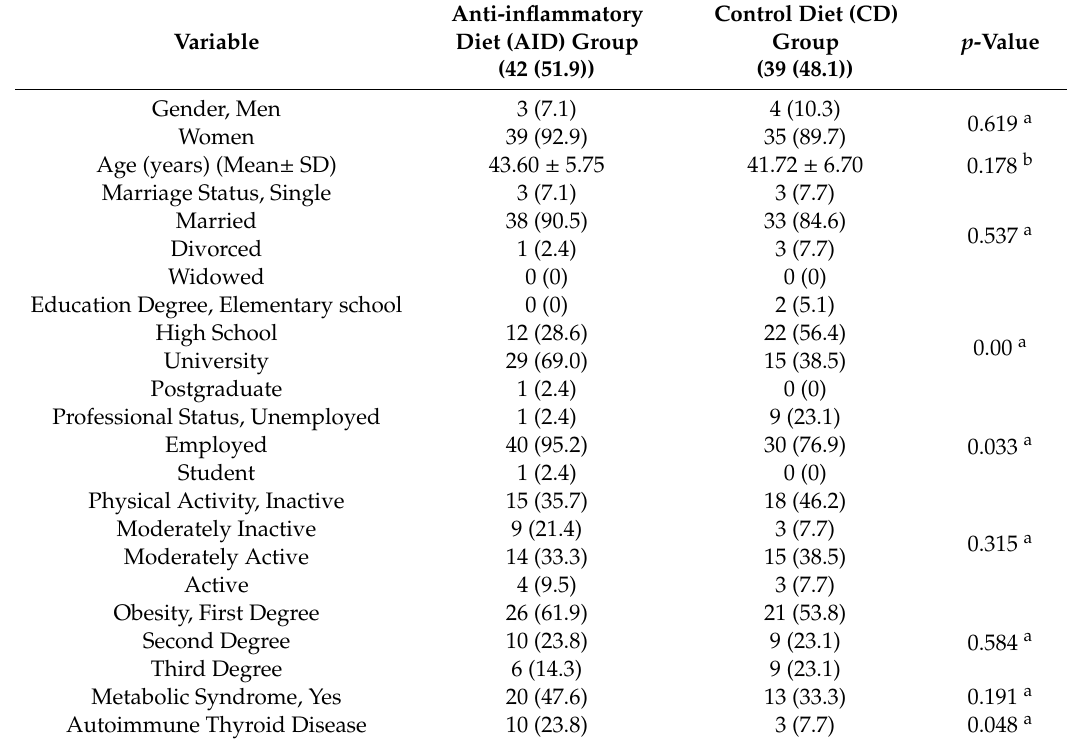
Table 1. Socio-demographic characteristics of the participants ( n =